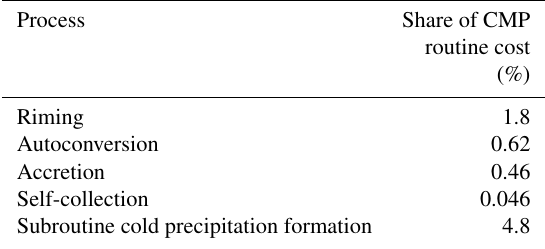
Table 1. Share of the computing time taken up by the cloud micro- physical processes investigated here. In turn, the CMP computing time represents 4.7% of total computing time (excluding diagnos- tics; all values averaged over a 12-month control simulation with η i = 1 ∀ i ). The time in the subroutine cold precipitation formation that is not attributed to the four processes is used for common ini- tializations and subsequent